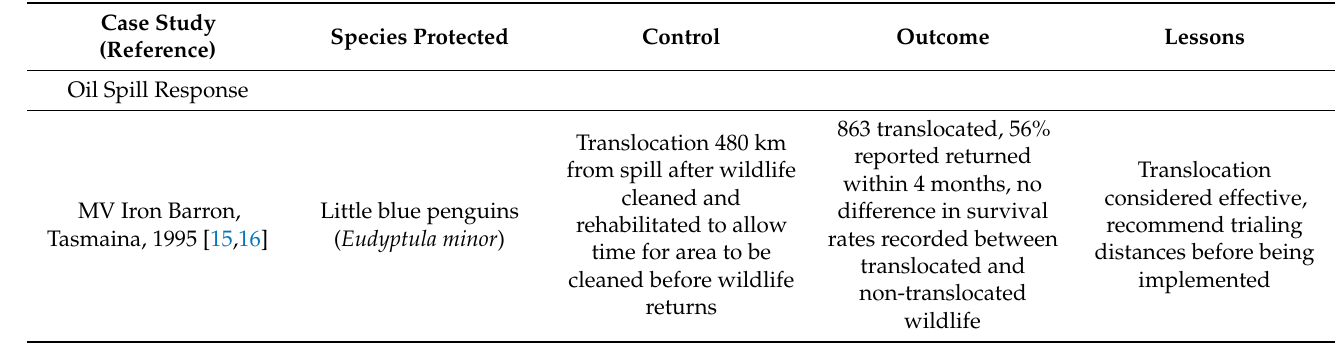
Case study summaries highlighting species protected, control measures, outcome and